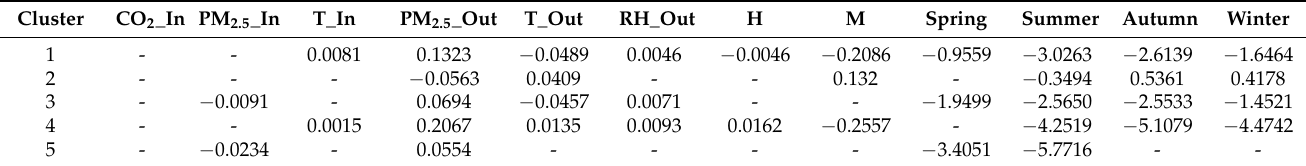
Table 7. The logistic regression estimates coefficients of the five clusters.